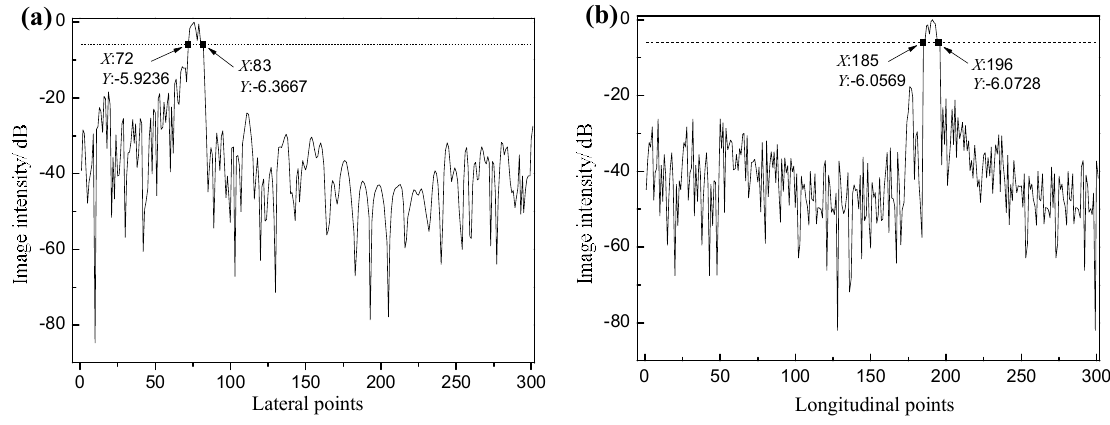
Figure 11. ( a ) Lateral and ( b ) longitudinal sound pressure distribution of defect hole 9.